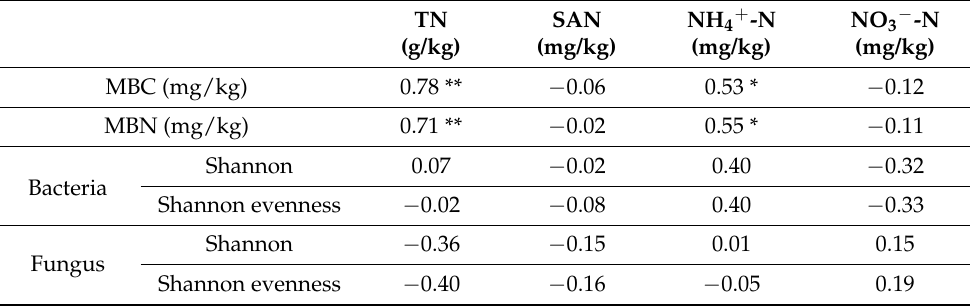
Table 2. Relationship between soil microorganisms and nitrogen